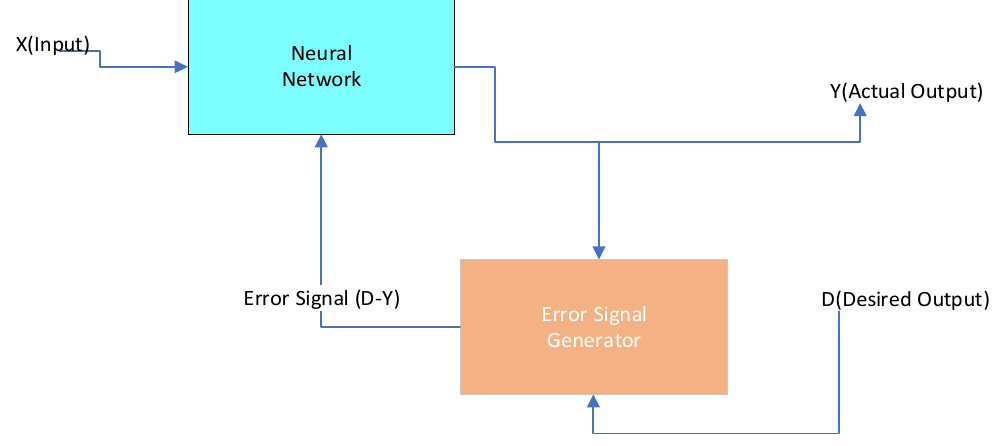
Figure 1. Artificial neural network architecture.